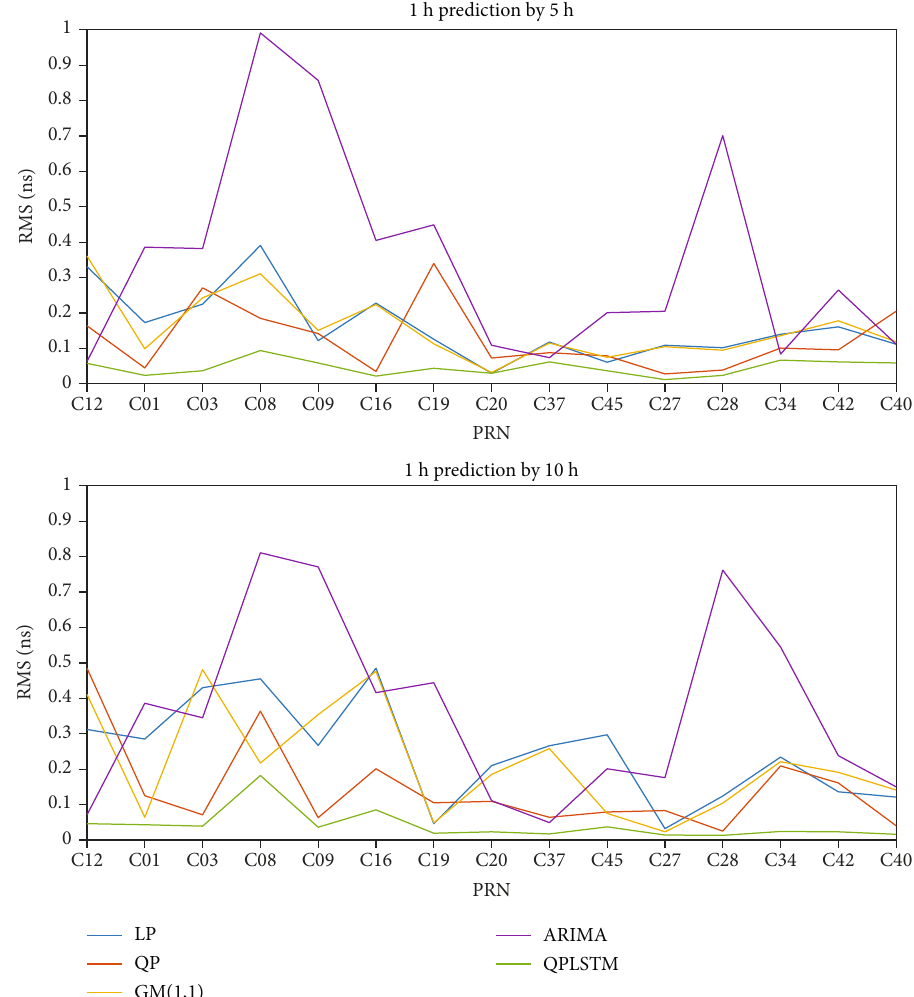
Figure 10: Prediction precisions for the fi ve models by 5 h and 10 h modeling for each BDS satellite. Table 7: 60min average prediction RMS for six di ff erent clock categories based on the fi ve models using 5 h or 10 h prior data. Clock